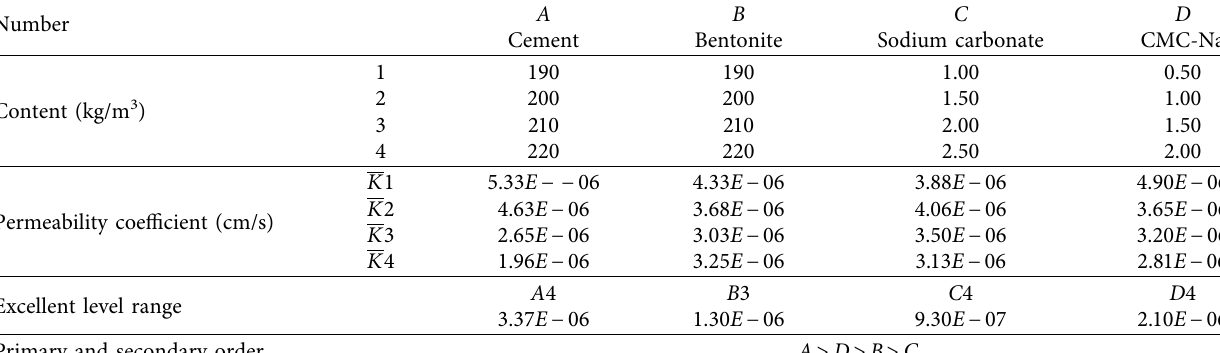
Table 3: Range analysis of 14-day permeability coefficient of samples.